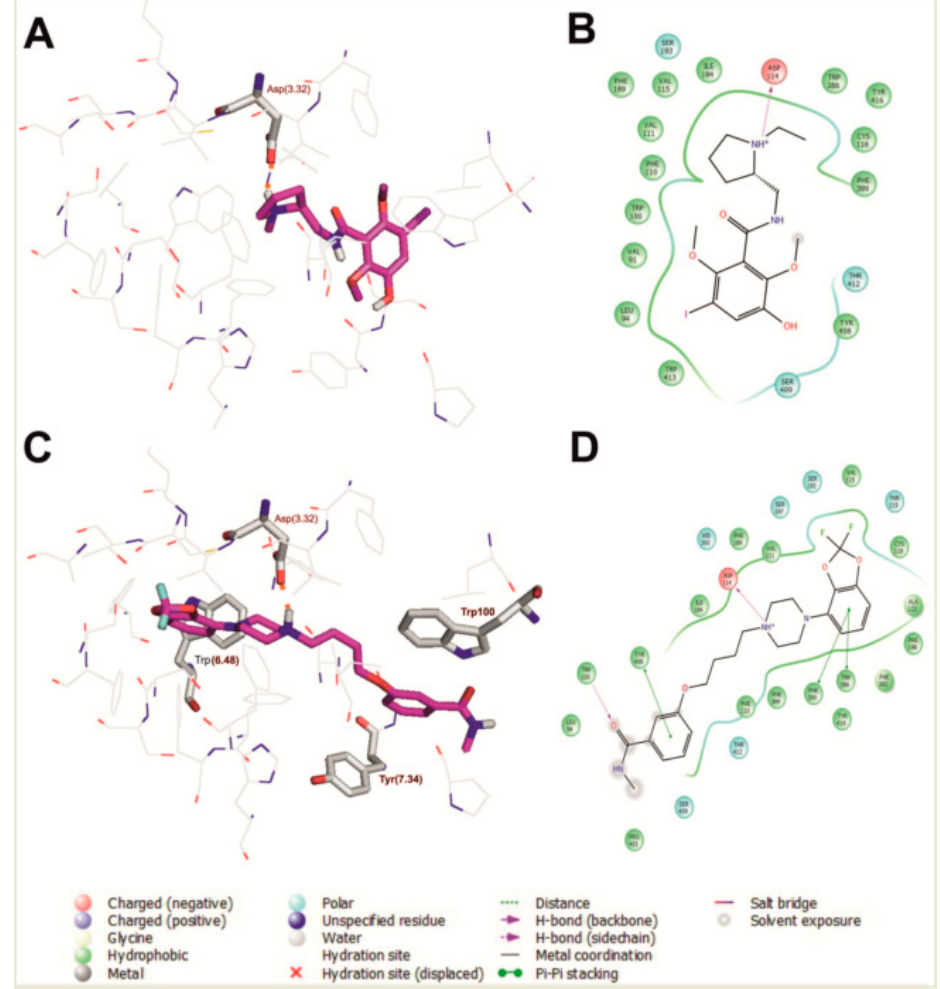
Figure 1. Compound 1 ( A , B ) and compound 17 ( C , D ) in the orthosteric binding site of the human dopamine D 2 receptor (selected molecular docking poses). ( A , C ) 3D view of the binding pocket. Ligands are shown as sticks with magenta representing carbon atoms. Receptors are shown as wires with grey representing carbon atoms, while the main interacting residues are represented as sticks. Hydrogen bonds are depicted as red dashed lines. Nonpolar hydrogen atoms are not shown for clarity. ( B , D ) 2D view of the binding pocket.